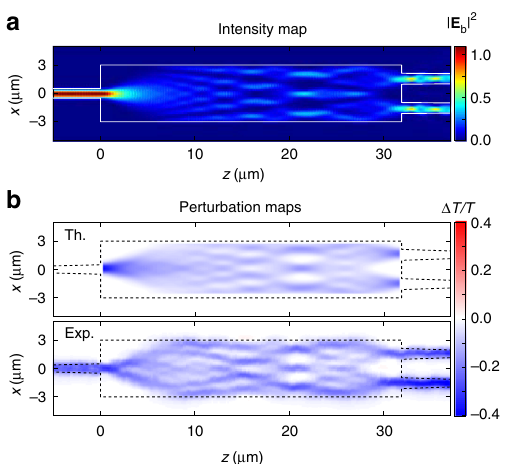
Fig. 5 Field intensity recovery for a 1 × 2 MMI. We considered here a MMI device with length L = 31.875 μ m and width W = 6.0 μ m, and covered by a silica cladding. a Simulated fi eld intensity map for excitation by the input waveguide fundamental mode. b Perturbation maps predicted with our model for the coupling between the fundamental mode of the input waveguide and the fundamental mode of the pair of output waveguides, and measured experimentally by combining the two MMI outputs using a reverse 2 × 1 MMI splitter